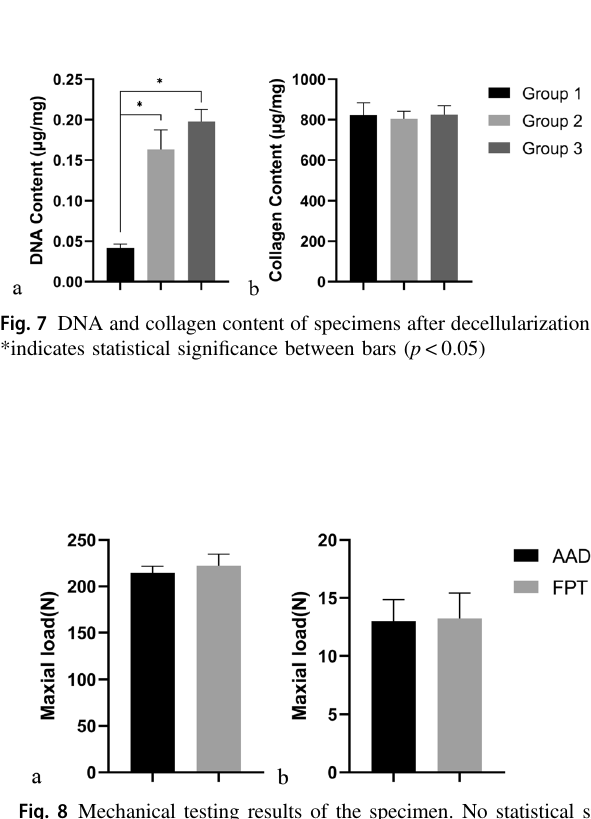
Fig. 9 MTT assay for proliferation of cells on specimen surface. No statistical signi fi cance was observed between AADL and collagen ( a , p > 0.05) or among the 24, 48, and 72 h time points ( b , p >